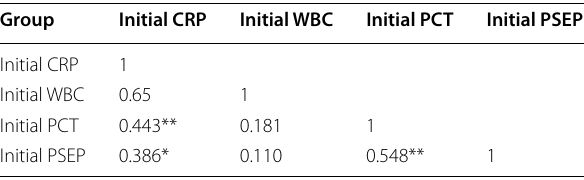
Table 4 Correlation between diagnostic